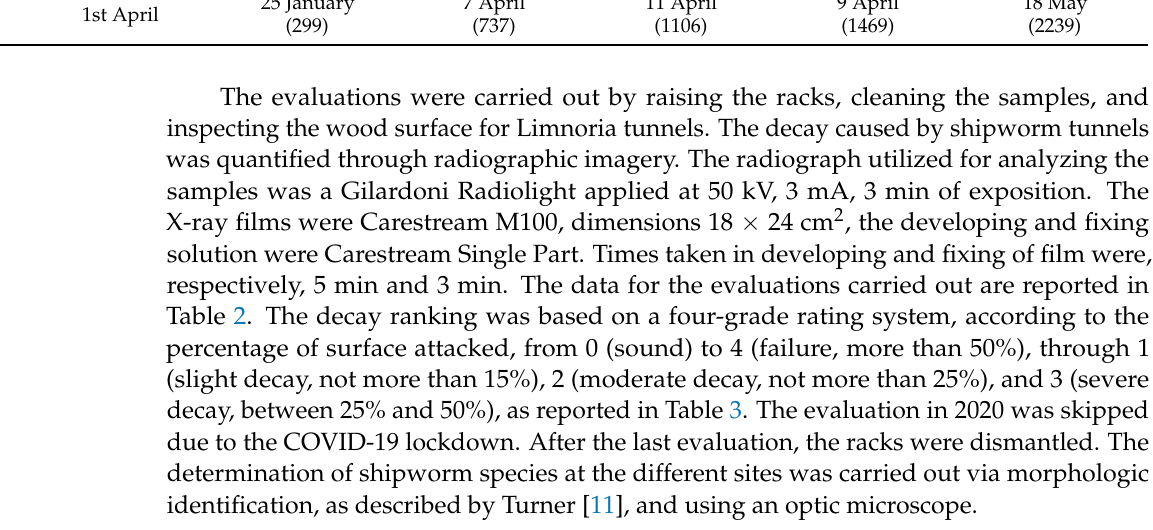
Table 3. Rating system for attack by teredinids according to EN